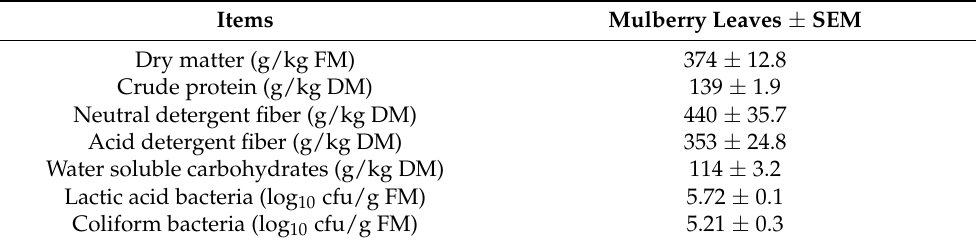
Table 1. The chemical composition and microbial population of pre-ensiled mulberry leaves.